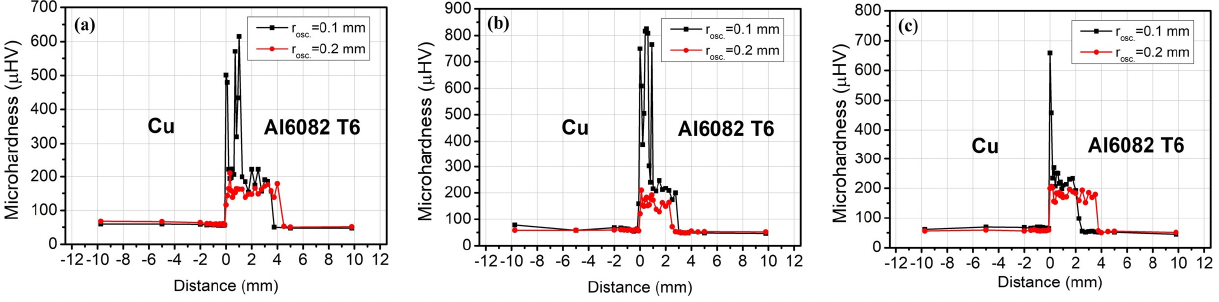
Figure 6. Microhardness in cross section of Cu/Al6082T6 samples along a line: ( a ) 1 mm below the top surface; ( b ) at the middle of the seam; ( c ) 1 mm above the seam